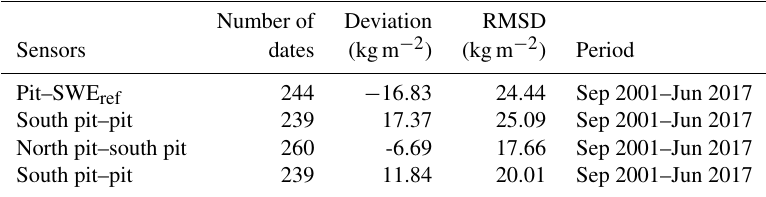
Table 6. Statistics of the comparisons between the different SWE measurements represented in Fig. 9. Number of Deviation RMSD Sensors